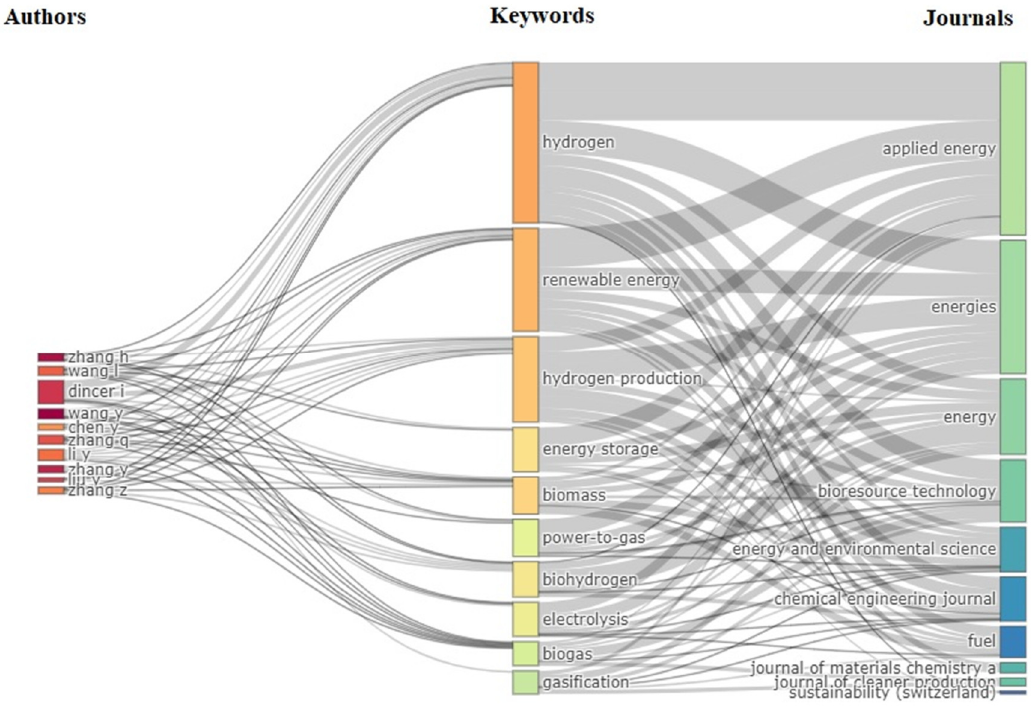
Figure 7. Tree fields plot illustrating the relationship between authors, keywords, and journals.